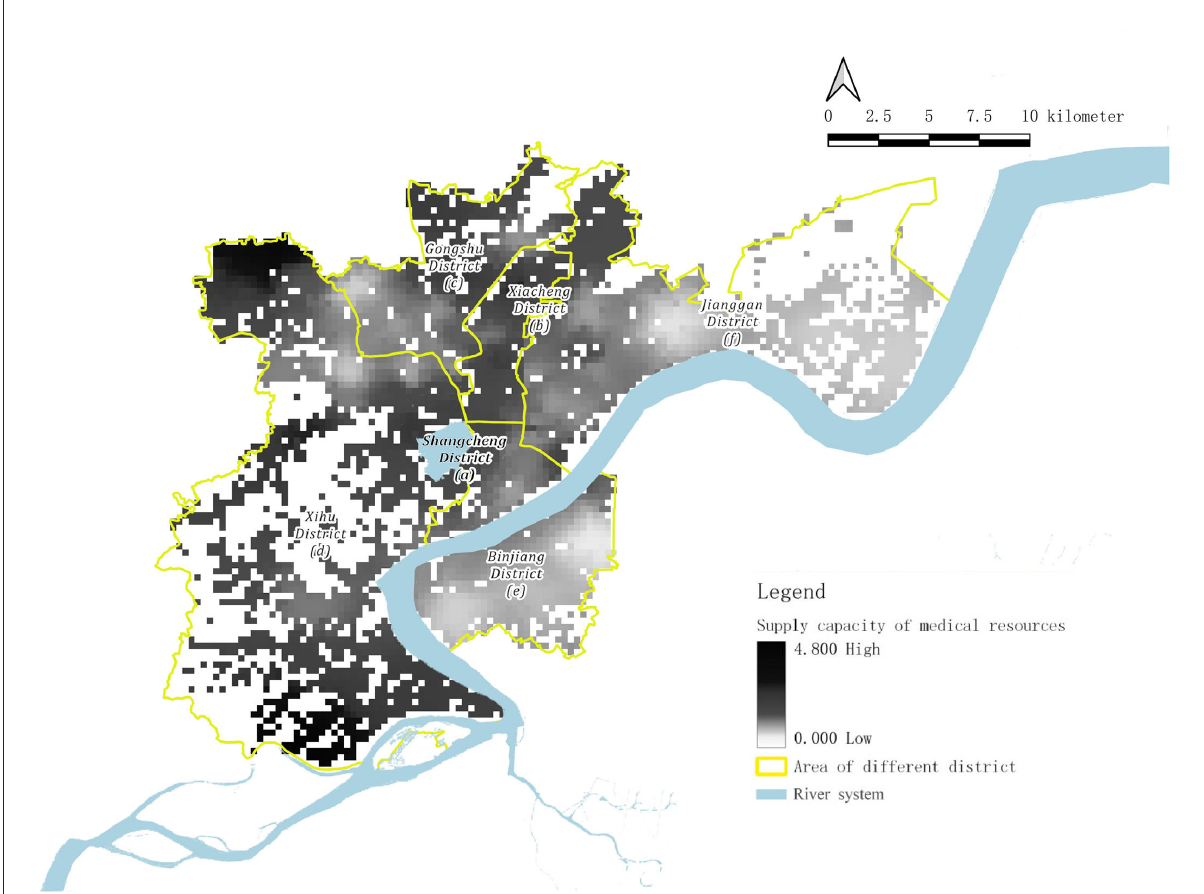
FIGURE3 Analysis chart of supply capacity of medical resources in six